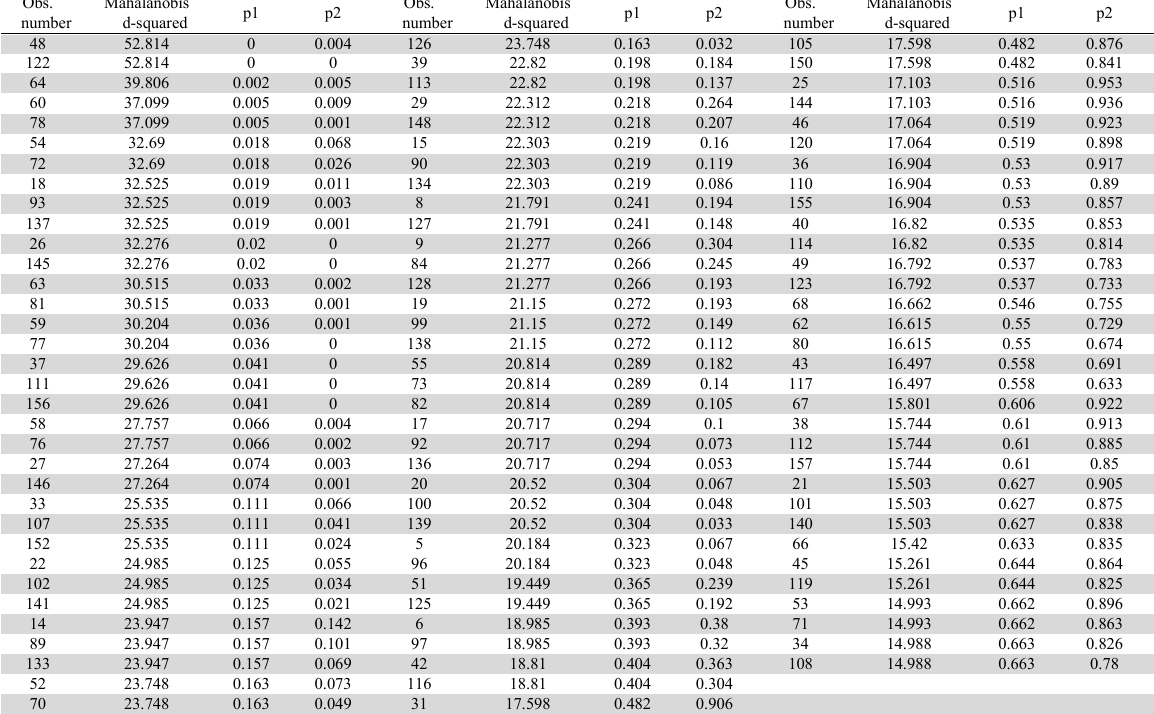
The summary of Mahalanobis distance for observations farthest from the centroid Obs.